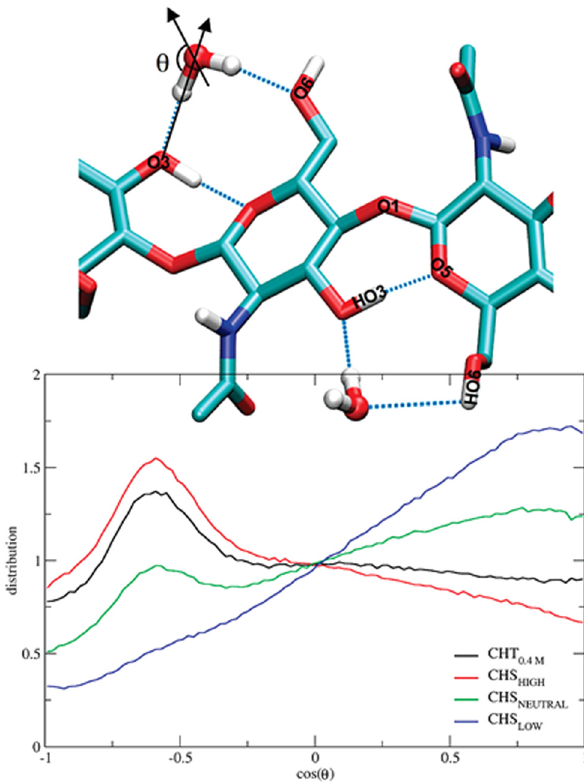
Figure 8: Solvent ( water ) orientation around the O3 oxygen atom of chitin and chitosan chains. Property is shown as the average orientation ( cos θ ) over the entire simulation for a 5 - Å radius around the O3 atom. θ is de fi ned by the angle formed between the vector formed by O3 and the water oxygen atoms and the water dipole vector ( as illustrated by the black arrows ) . Hydrogen bonds are represented by dashed blue lines. Water molecules are displayed in a ball - and - stick model and the sugar units of chitin are in sticks ( atoms are color coded as follows: cyan, carbon; blue, nitrogen; red, oxygen; white, hydrogen ) . Image reprinted with permission from [ 58 ] . Copyright ( 2008 ) American Chemical